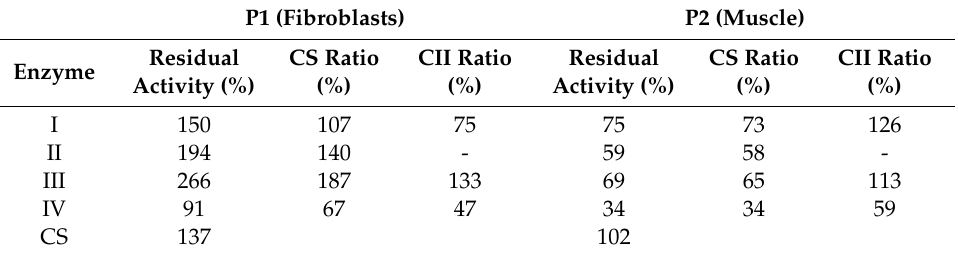
Table 1. Spectrophotometric analysis of oxidative phosphorylation (OXPHOS) enzyme activities in fibroblasts from P1 and muscle from P2.